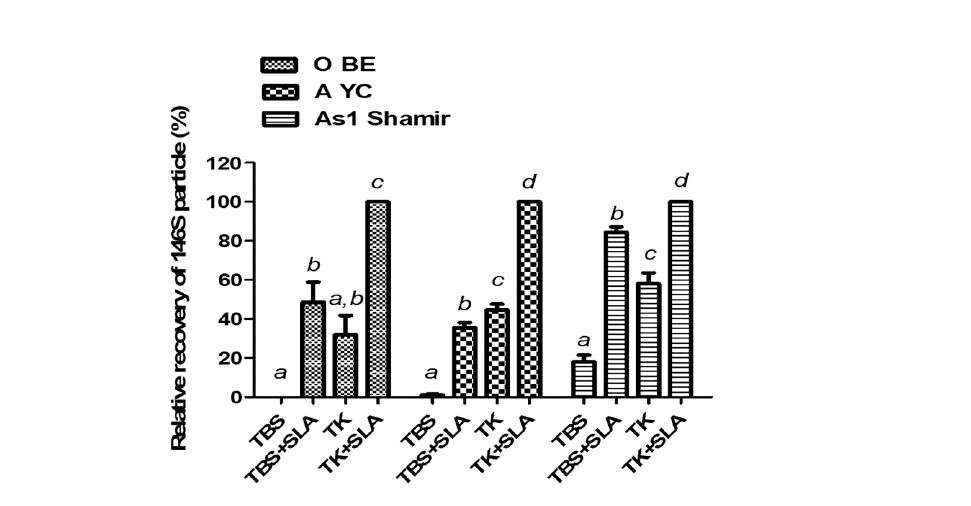
Figure 5. Compatibility of the candidate stabilizer composition with other FMDV strains. Relative recovery (%) was calculated from the remaining content of the 146S antigen after heating at 50 °C for 30 min when the antigen content of SLA in TK is set as 100%. Different lowercase letters indicate significant differences at p < 0.05. Abbreviations: O BE, O SKR/BE/2017; A YC, A SKR/YC/2017; As 1 Shamir, Asia 1 Shamir/ISR/1989; TBS, Tris-buffered saline (pH 7.6); TK, Tris- KCl buffer (pH 7.6); SLA, 10% sucrose with 5% lactalbumin hydrolysate.